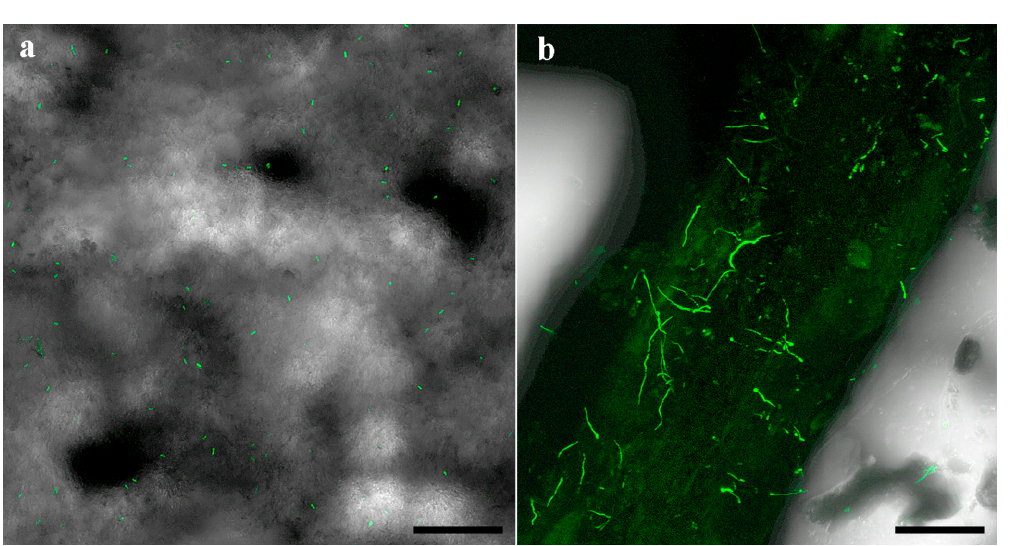
Figure 10 . Confocal laser scanning micrographs of Mb7-GFP treated soil ( a ) and root ( b ) samples at 42 days after planting. Scale bar = 0.1 mm.